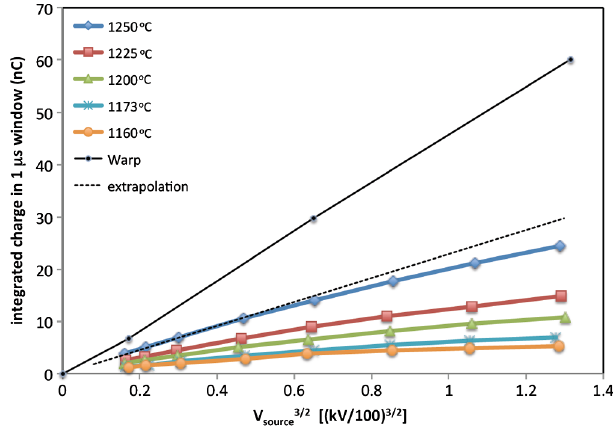
FIG. 6. Extracted beam current, integrated over (cid:2) 1 (cid:1) sec duration near the beginning of the current waveform vs injector voltage, for several source temperatures.